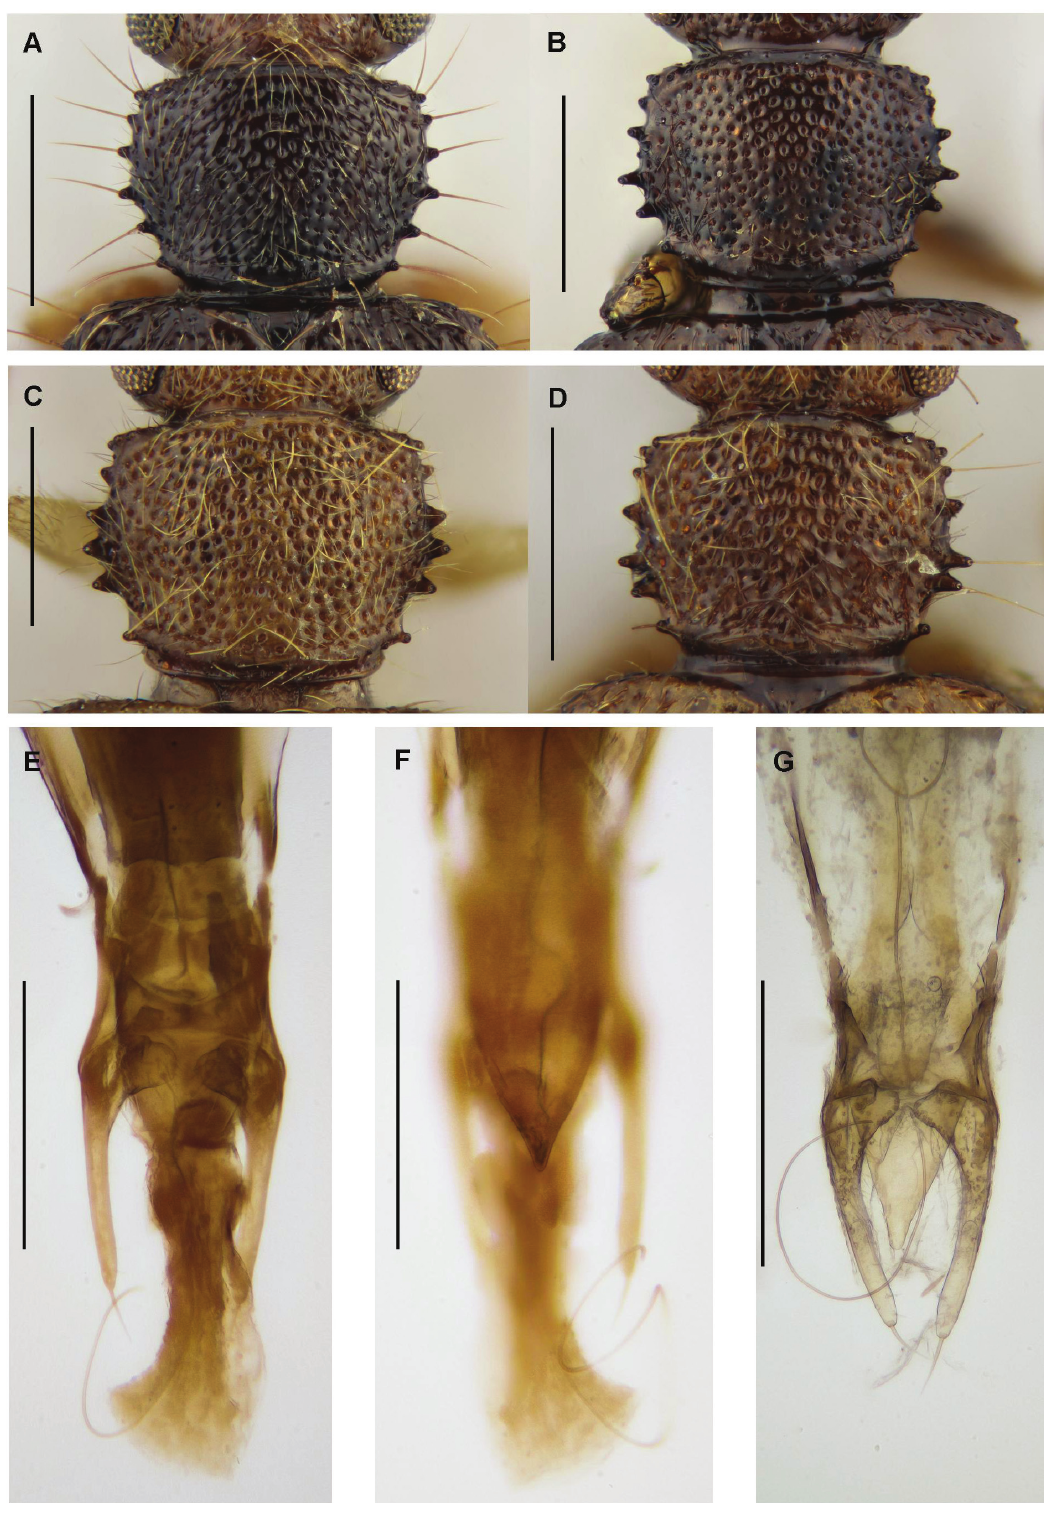
Fig. 7. Psammoecus laetulus Grouvelle, 1914. Pronotum of specimens from A . Mahe, Seychelles. B . Cape Province, South Africa. C . KwaZulu-Natal, South Africa. D . Mpumalanga, South Africa. E–F . Aedeagus of specimen from Mahe, Seychelles (E = dorsal, F = ventral view). G . Aedeagus of specimen from Mpumalanga, South Africa, dorsal view. Scale lines: A–D = 0.5 mm, E–G = 0.2